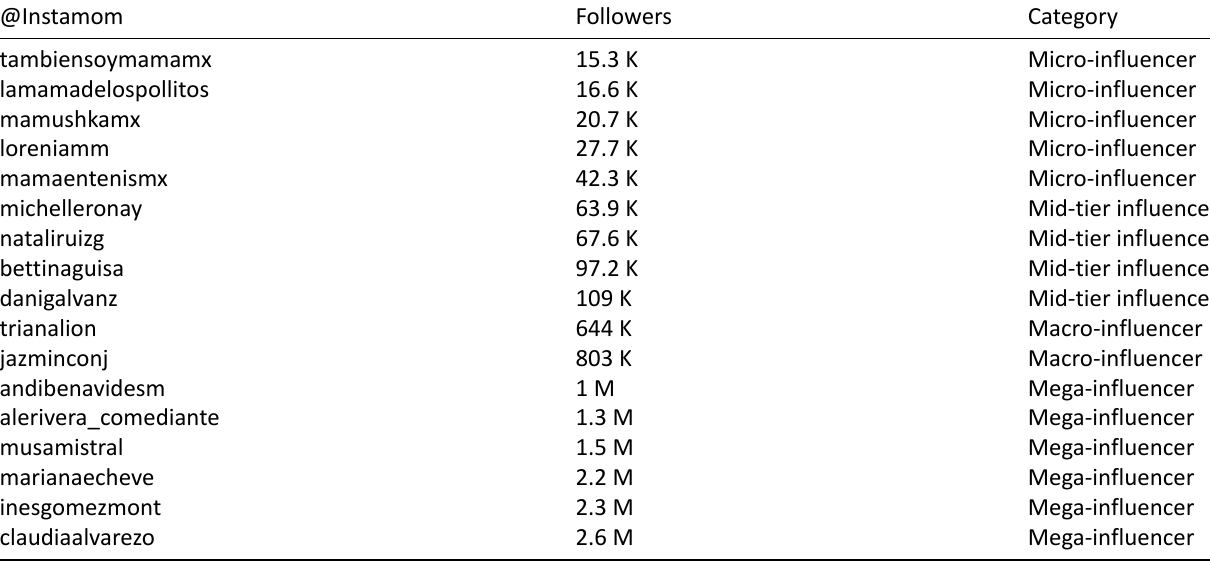
Table 3. Instamom